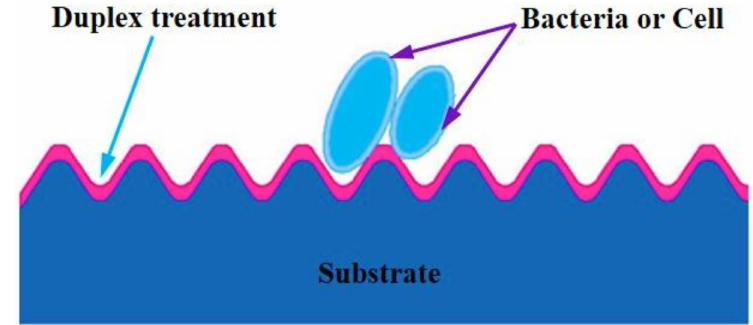
Figure 3. Schematic diagram of adhesion of bacteria or cell on a duplex treated